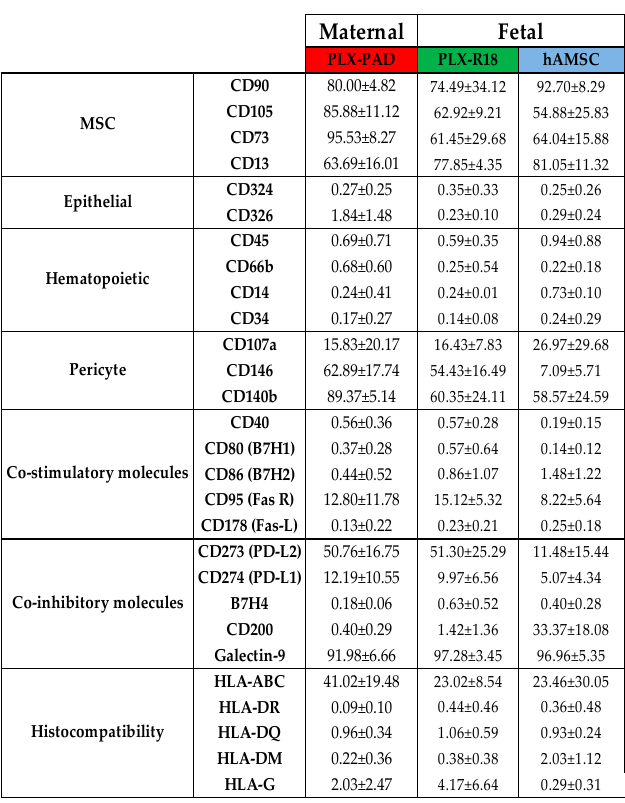
Figure 1. Phenotype analysis of cells derived from different batches of maternal (PLX-PAD R06 and R08) and fetal (PLX-R18 and hAMSC) placental tissues. Immune phenotype screening of the three different cell populations. Phenotype was analyzed by flow cytometry and data are presented as mean ± SD (*** p < 0.001, **** p < 0.0001). Results were obtained from biological replicates obtained from different experiments ( n ≥ 3 individual experiments).